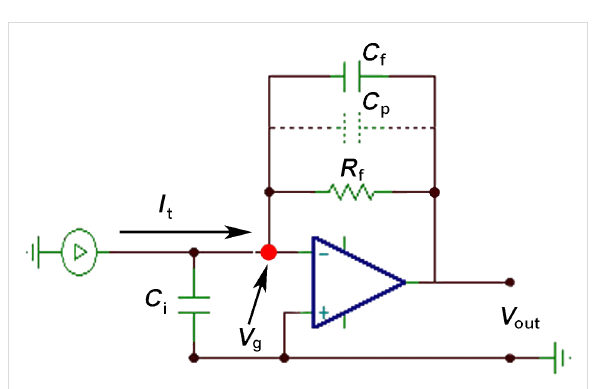
Figure 2: Circuit diagram of a current-to-voltage converter (IVC) where R f is the feedback resistance with the parallel capacitance C f . C i is the input capacitance (in addition to the one of the amplifier). C p repre- sents the parasitic capacitance of the feedback resistor. The input of the operational amplifier floats at the virtual ground potential ( V g